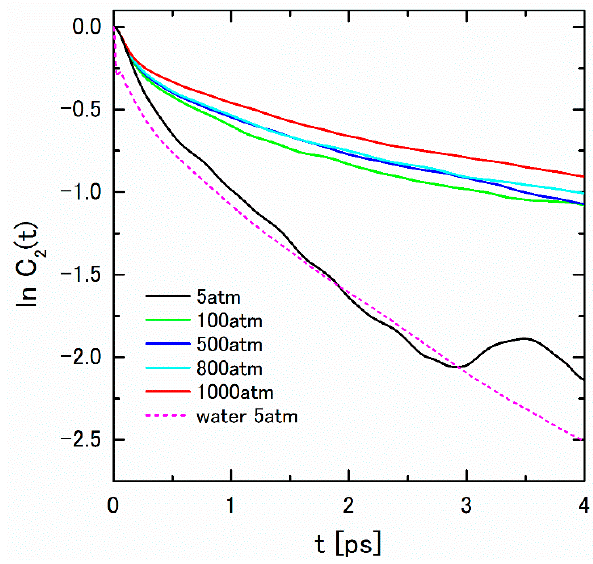
Figure 9. ln C 2 ( t ) of HCO 3 − under pressures of 5–1000 atm with log C 2 ( t ) of water under 5 atm.